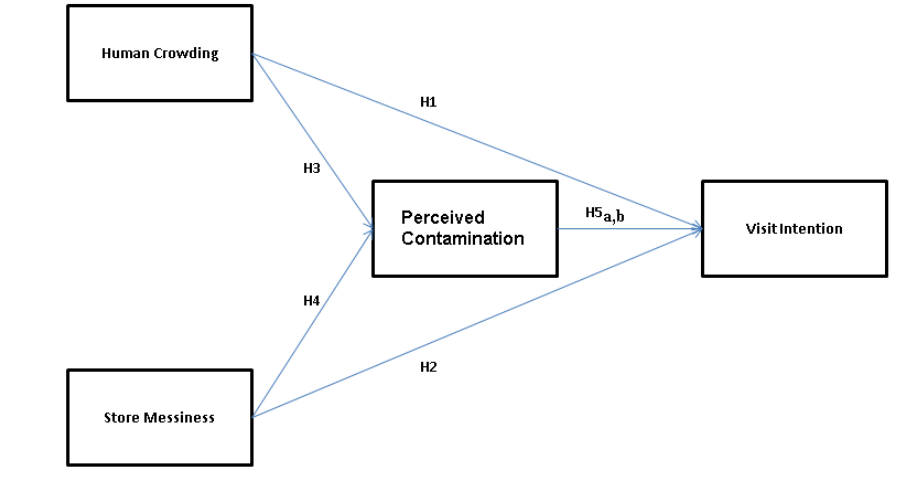
Figure 1: Conceptual